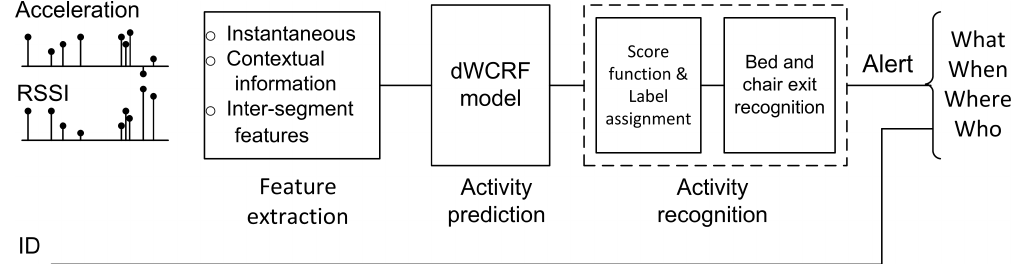
Figure 2. Proposed bed and chair exit recognition approach. Acceleration data from the sensor and additional information such as the received strength of the signal (RSSI) evaluated by the RFID reader are inputs to the recognition approach.